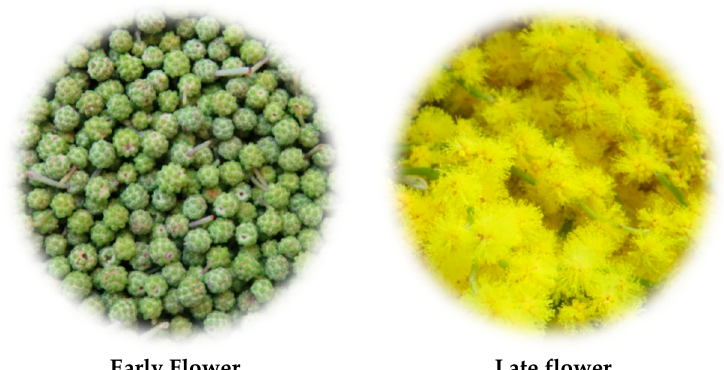
Figure 4. Examples of different flowering stages used in this